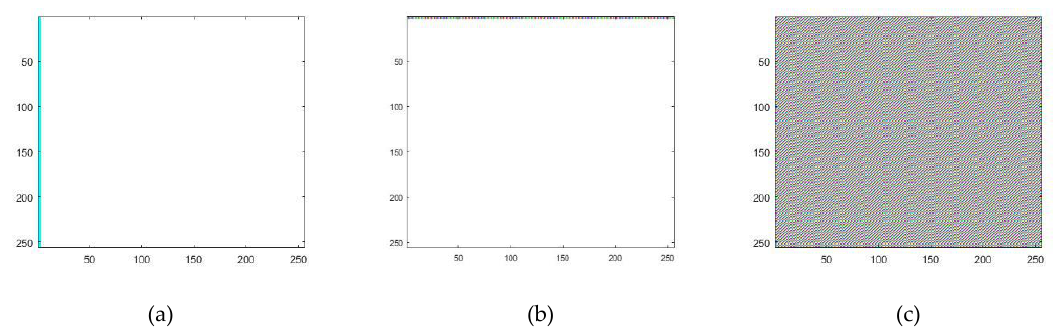
Figure 2. Images corresponding to the three division plaintext sequences: (a) Image corresponding to S, (b) Image corresponding to R, (c) Image corresponding to U.